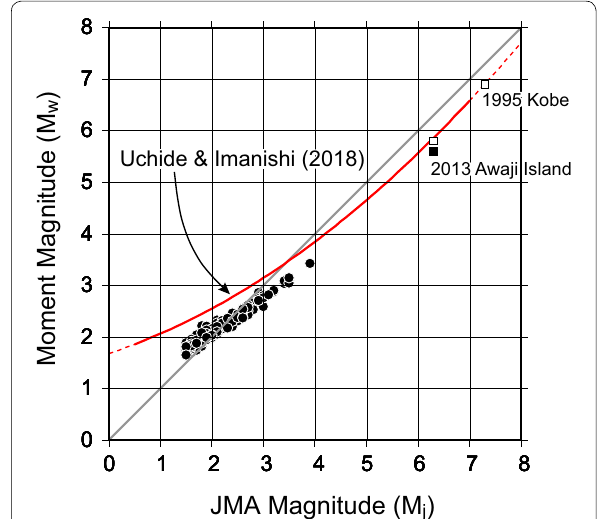
Fig. 14 Comparison of the moment magnitude (M w ) determined in the present study and the JMA magnitude (M j ). Open squares are from the centroid moment tensor solution by JMA, and filled square is from the slip model in this study. The gray line denotes M w The red curve is the M j –M w scaling determined in another area in Japan (Uchide and Imanishi